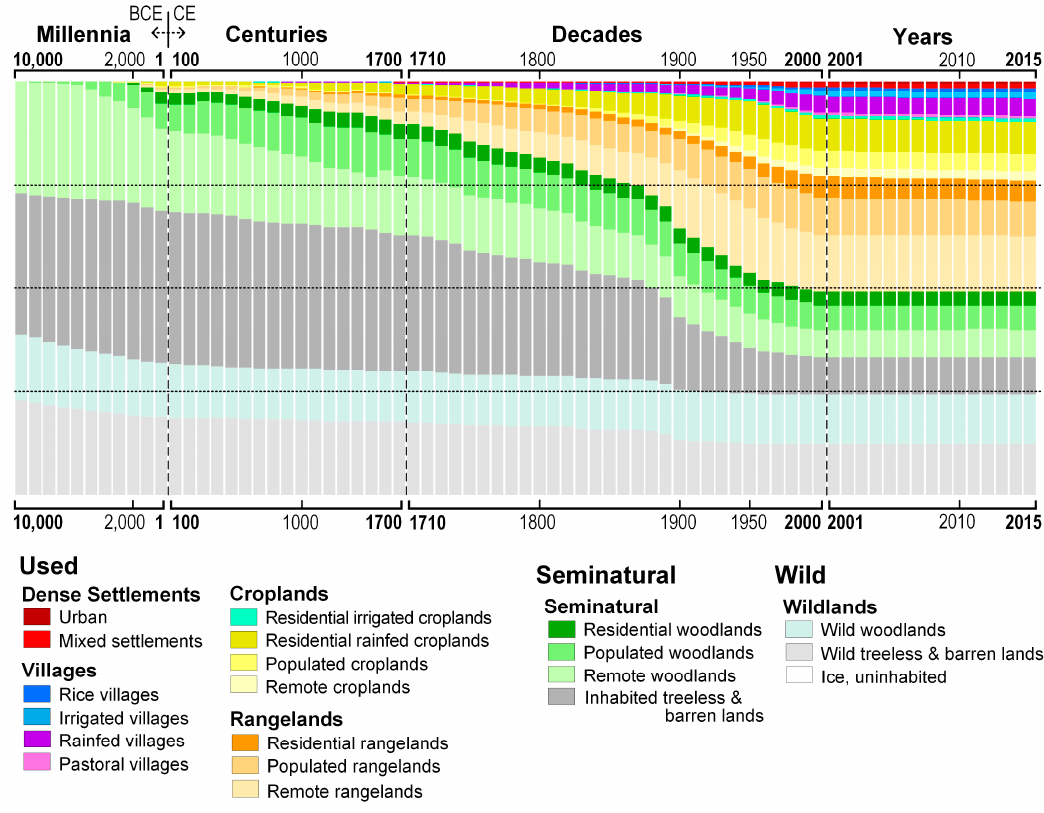
Figure 3. Changes in anthrome areas from 10,000 BCE to 2015 CE for all time intervals in the Anthromes 12K dataset. Relative global areas are indicated using stacked bars, which add up to the total global land area, not including Ice, uninhabited, which showed no significant changes over time.